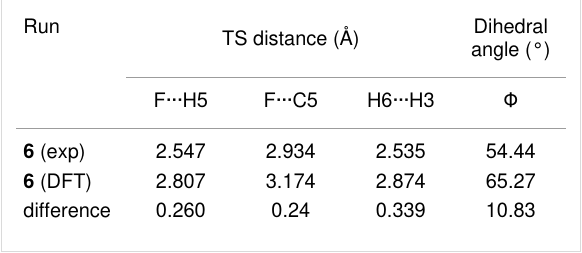
and H5 for the optimized structure is 2.807 Å which is relative- ly close to that of the crystal structure (2.547 Å). Selected com- parisons are shown in Table 2.